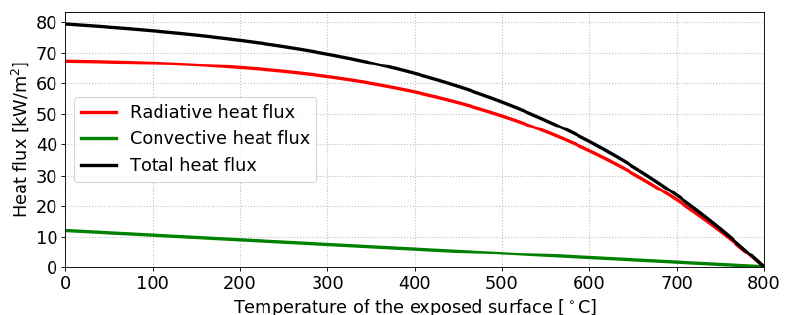
Figure 5. Heat flux across an exposed surface for T AST = 800 ◦ C, ε = 0.9 and h = 15 W/m 2